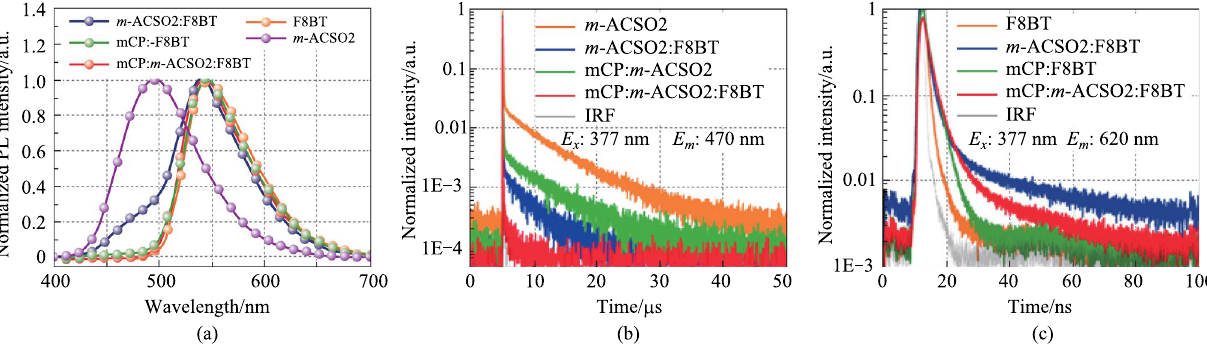
Fig. 3 a PL spectra of m -ACSO2, F8BT and different hosts:F8BT (10 wt%) in the film. b Transient PL decay curves of the host-only films and the films with F8BT detected at 470 nm. c Transient PL decay curves of different films with F8BT detected at 620 nm at 300